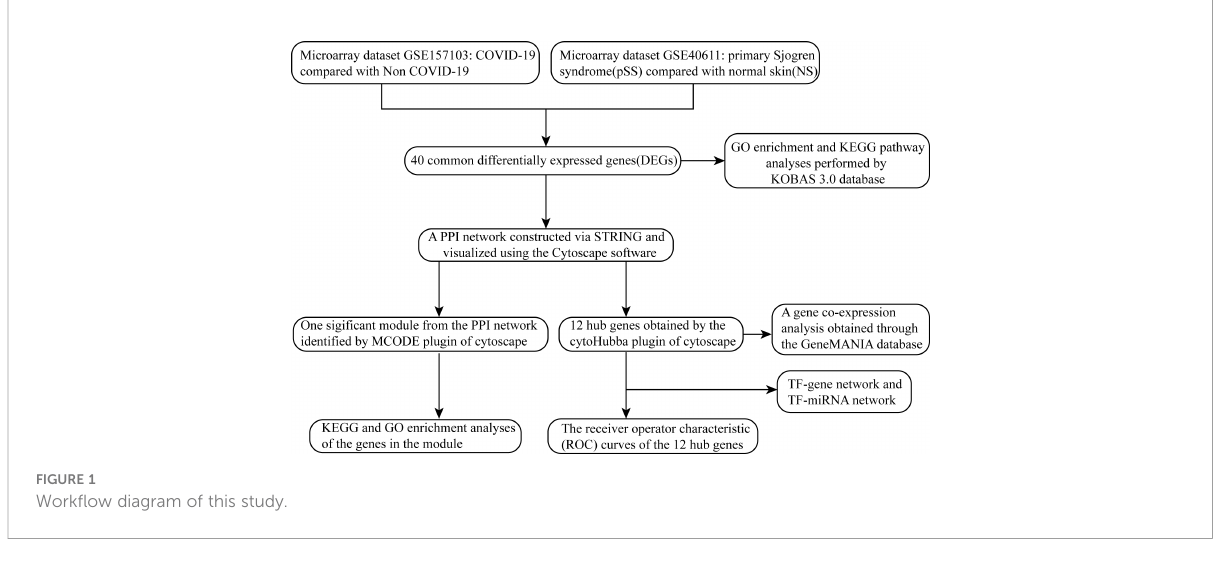
FIGURE 1 Work fl ow diagram of this